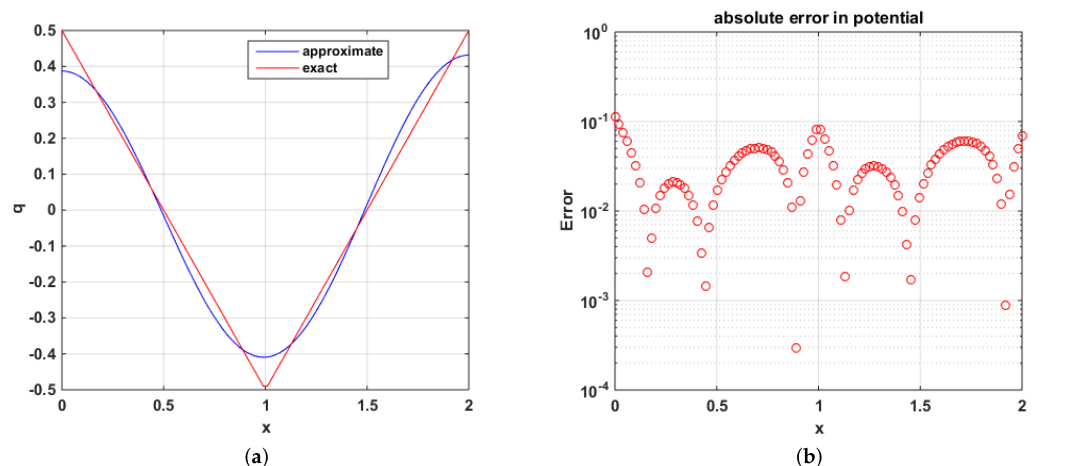
Figure 3. ( a ) Reconstructed potential (blue) and exact potential (red) p ( x ) = | 1 − x | − 0.5 ( b ) Log absolute error in the reconstructed p